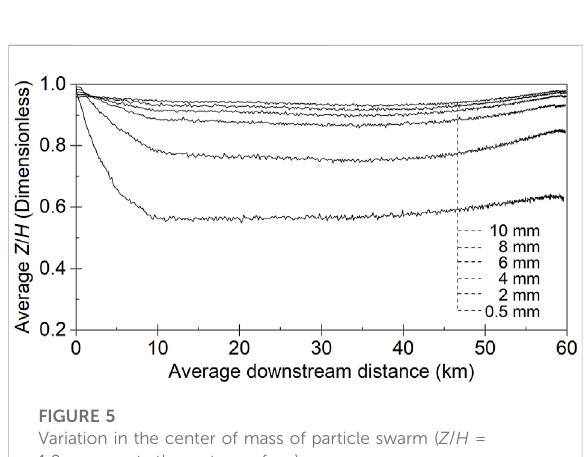
Statistics on distance drifted downstream by particles (particle diameter 0.5 mm).